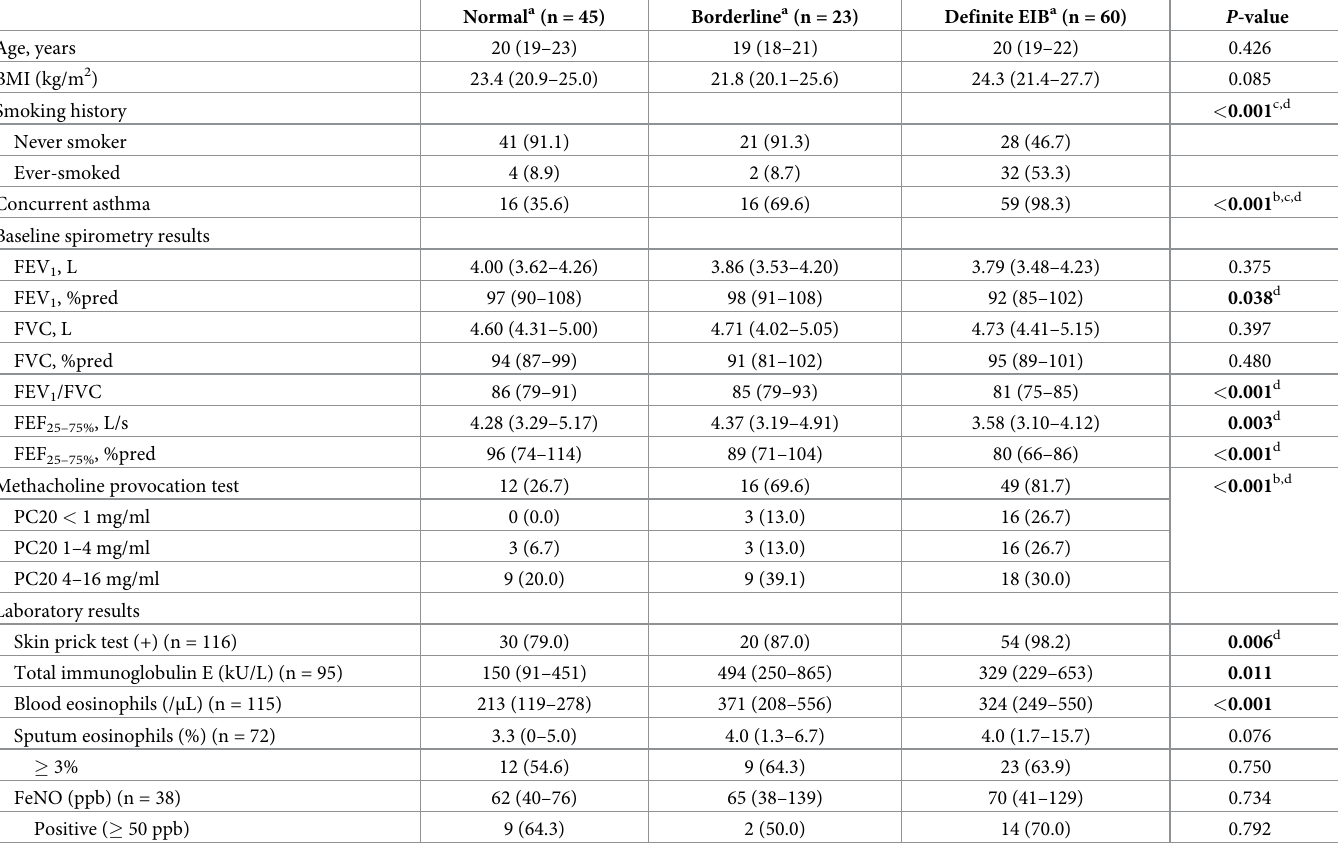
Table 1. Baseline characteristics of the study